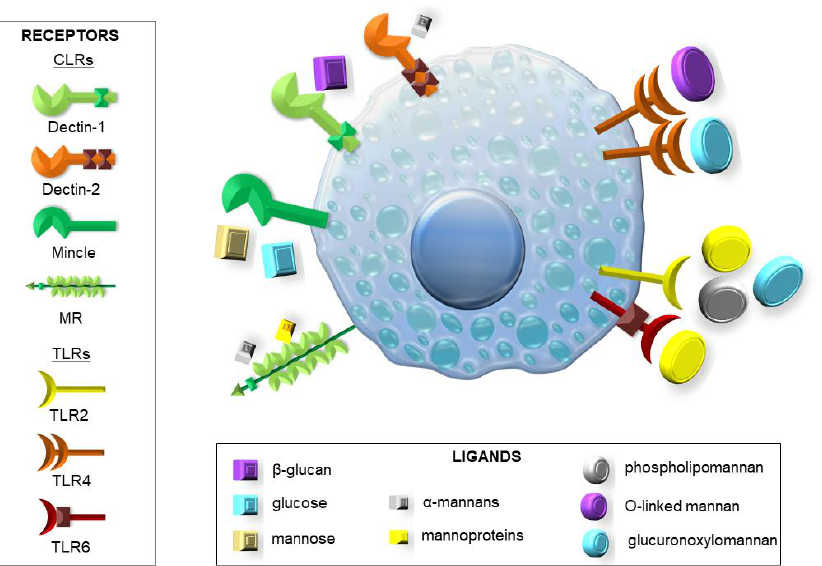
Figure 2. Expression of PRRs involved in sensing different fungal components on MCs.